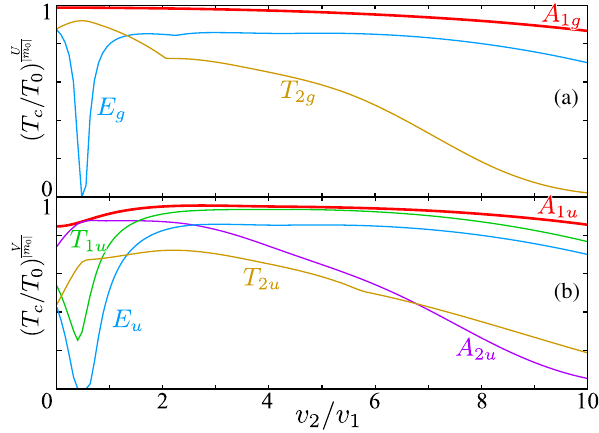
FIG. 2. Transition temperature for (a) even- and (b) odd- parity superconducting states. The unit temperature is T 0 ¼ ½ð 2 e γ ℏ ω 0 Þ = ð π k B Þ(cid:3) with Euler ’ s constant γ and cutoff frequency ω 0 . Here, the parameters are β